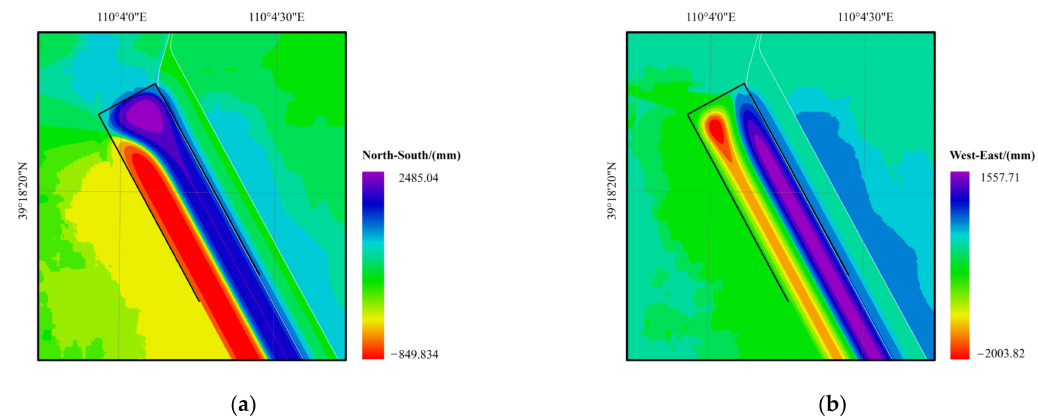
Figure 19. Horizontal movement in the north–south ( a ) and east–west ( b ) directions.